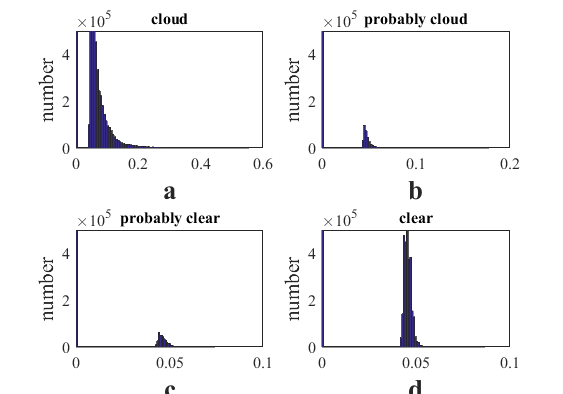
Figure 2. The numerical distribution of R0.1.375. Figures a, b, c, and d are the numerical distributions of R1.375 in the case of “cloud”, “probably cloud”, “probably clear”, and “clear”.